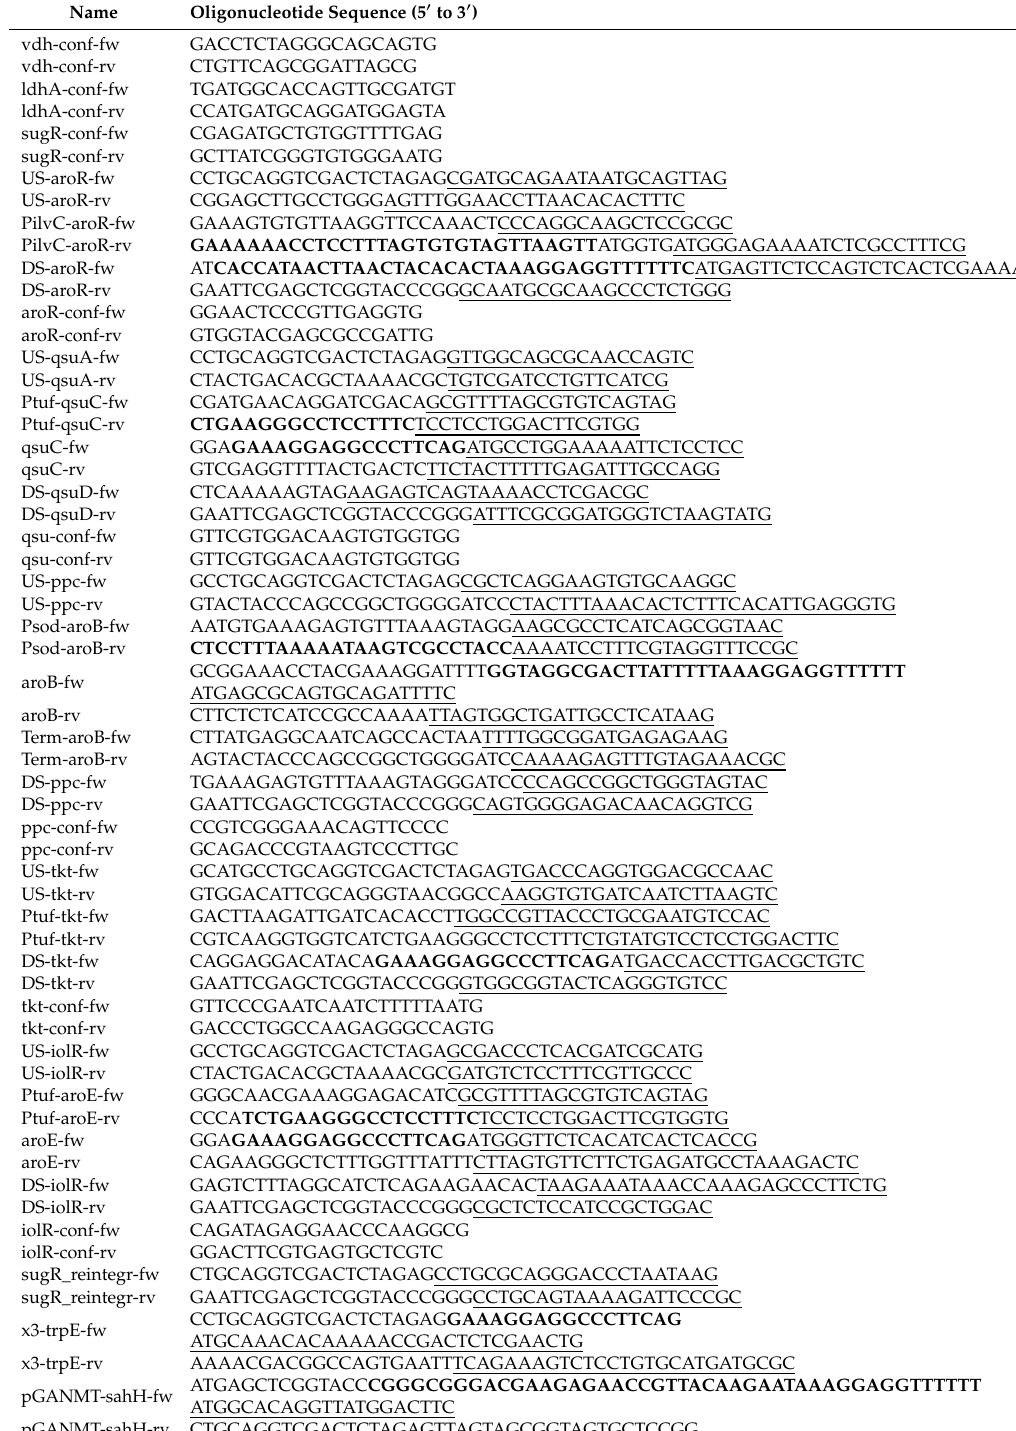
Table 2. Oligonucleotides used in this